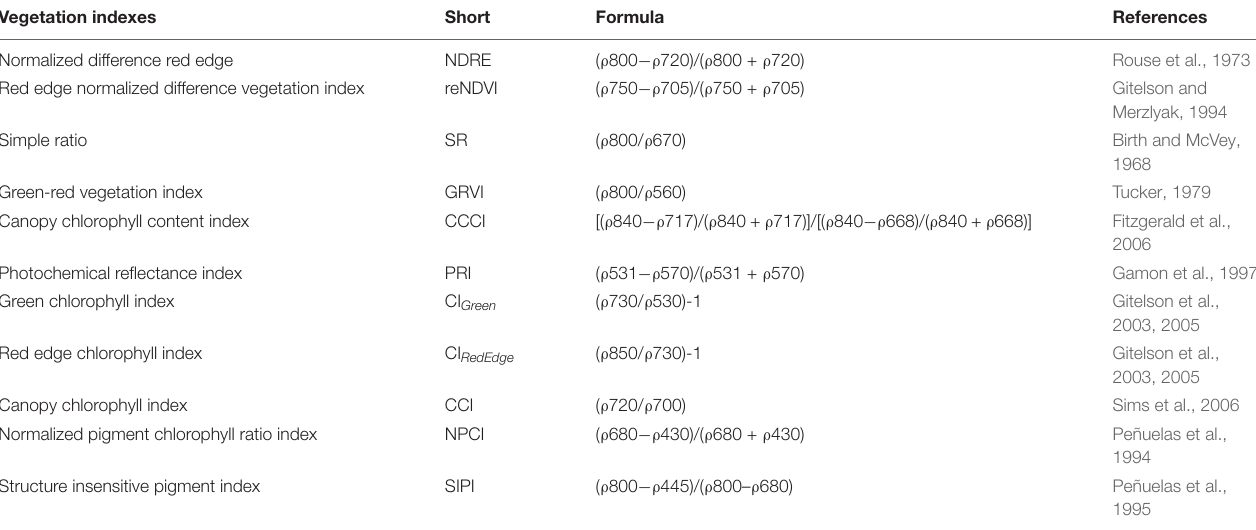
TABLE 1 | Different vegetation indices (VIs) used in this